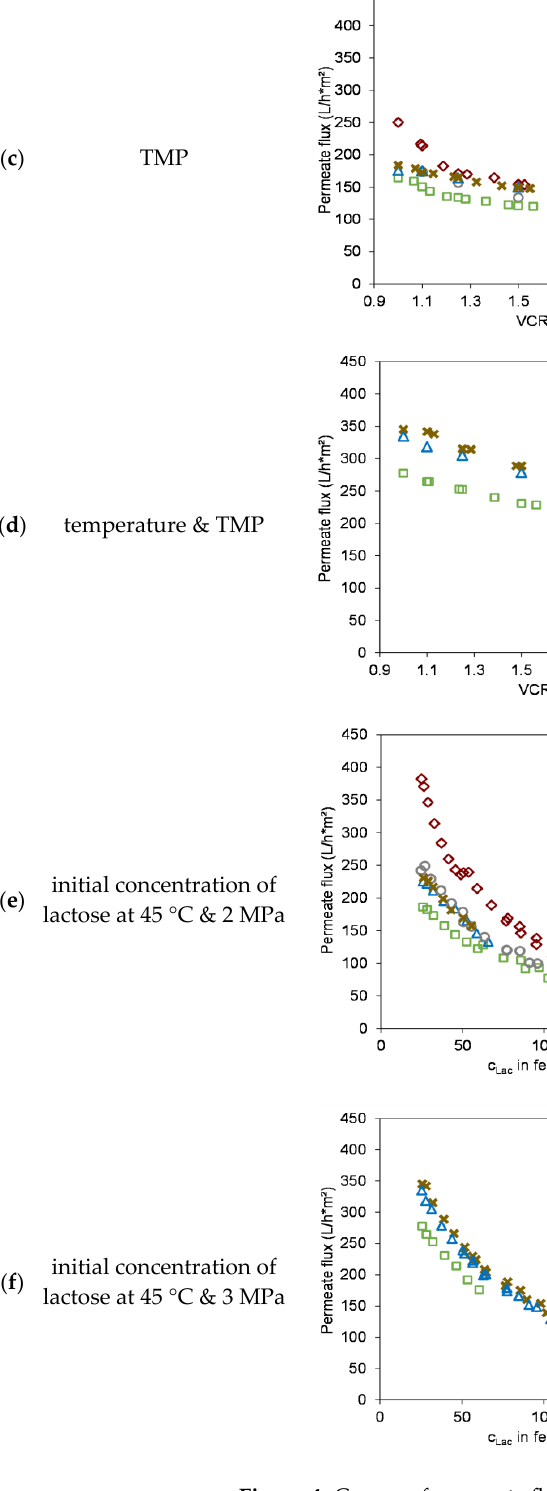
Figure 4. Course of permeate flux (left side) and retention of lactose (right side) during concentration of lactose in dependency of varying process parameters; ( a ) standard parameter (20 ◦ C; 2 MPa; 25 g/L lactose); ( b ) temperature (45 ◦ C); ( c ) transmembrane pressure (TMP) (3 MPa); ( d ) temperature and TMP (45 ◦ C & 3 MPa); ( e ) initial concentration of lactose in feed (45 ◦ C; 2 MPa; 25–75 g/L initial feed-c); ( f ) initial concentration of lactose in feed (45 ◦ C; 3 MPa; 25–75 g/L initial feed-c). Operation parameters summarized in Table